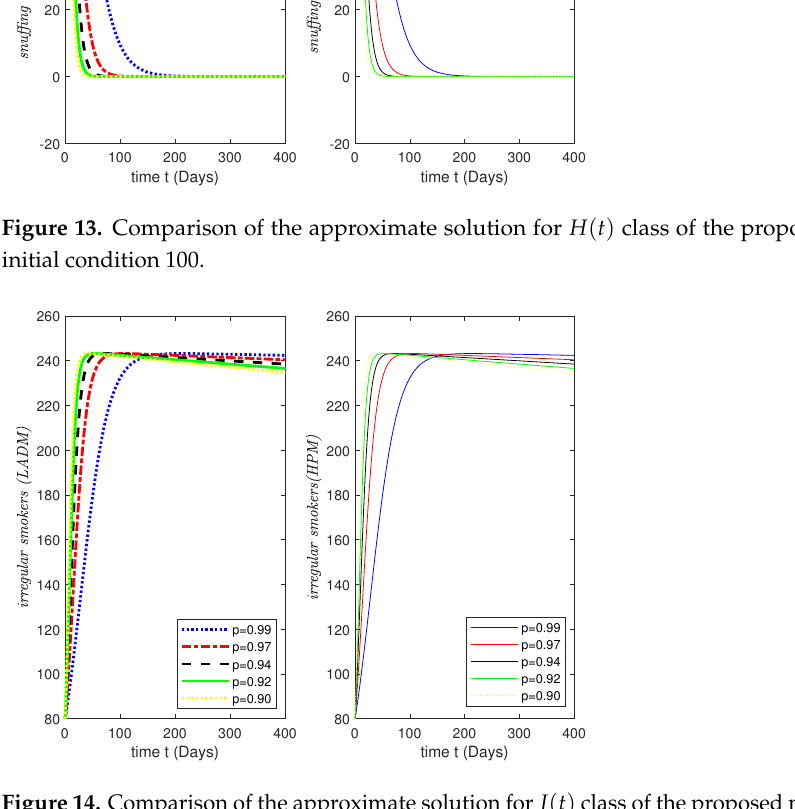
Figure 14. Comparison of the approximate solution for J ( t ) class of the proposed model having initial condition 80.